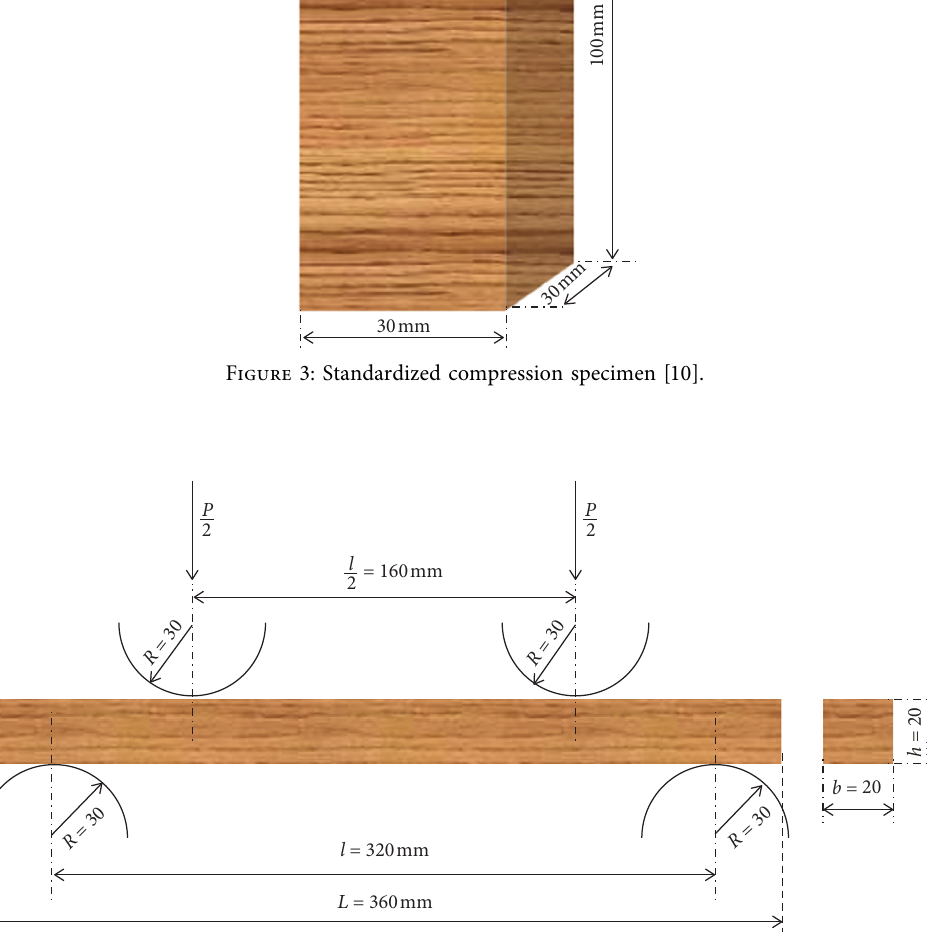
Figure 4: Standardized diagram of the experimental 4-point bending device